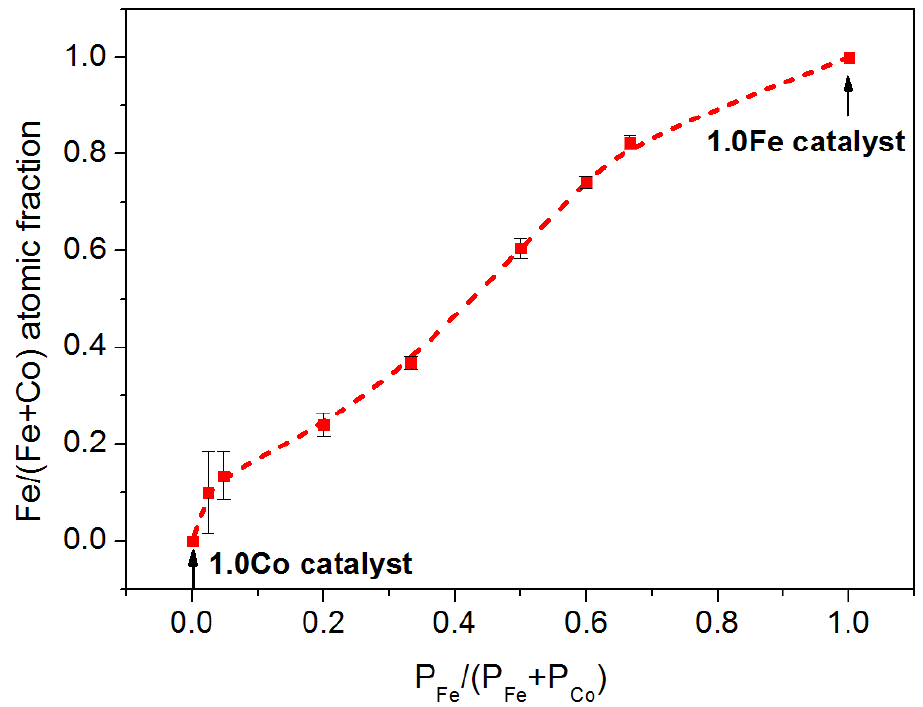
Figure 1. Composition of Fe–Co thin films as a function of the ratio of precursor pressures P Fe /(P Fe + P Co ). The pressure of iron precursor was varied in the range (0–0.4) Pa while keeping the pressure of cobalt precursor constant at 0.2 Pa.